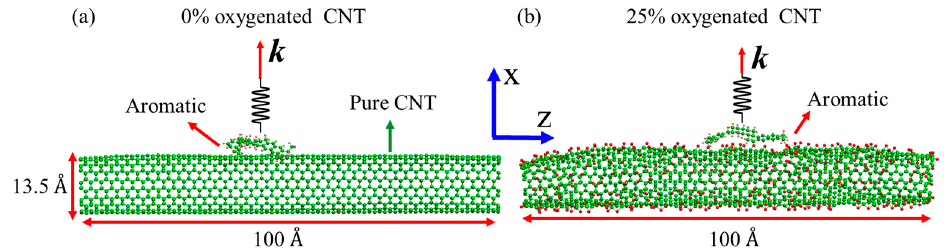
Figure 2. Molecular dynamic set up of Aromatic molecule on the surface of CNT before steering and after equilibration. ( a ) 0% oxygenated CNT and ( b ) 25% oxygenated CNT.